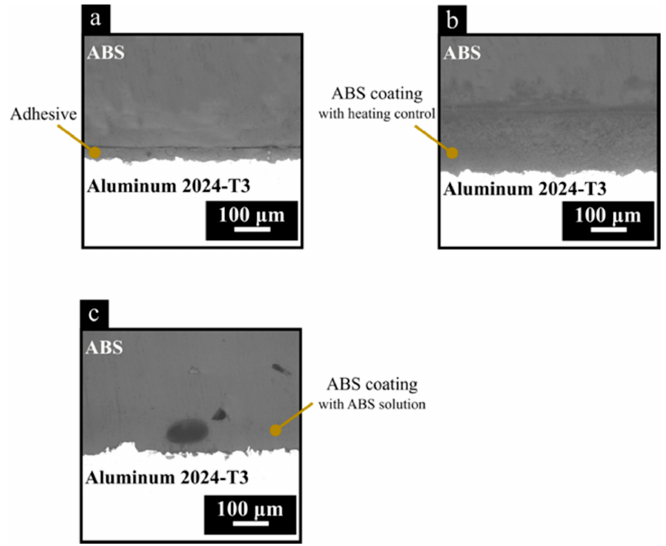
Figure 4. Microstructure of overlap joints from the investigated AddJoining process variants: ( a ) process variant one (with adhesive), ( b ) variant two (with heating control) and ( c ) variant three (with thin-coating layer). Specimens for microscopy were cut from the overlap zone in the longitudinal direction from lap-shear testing specimens, Figure 2.